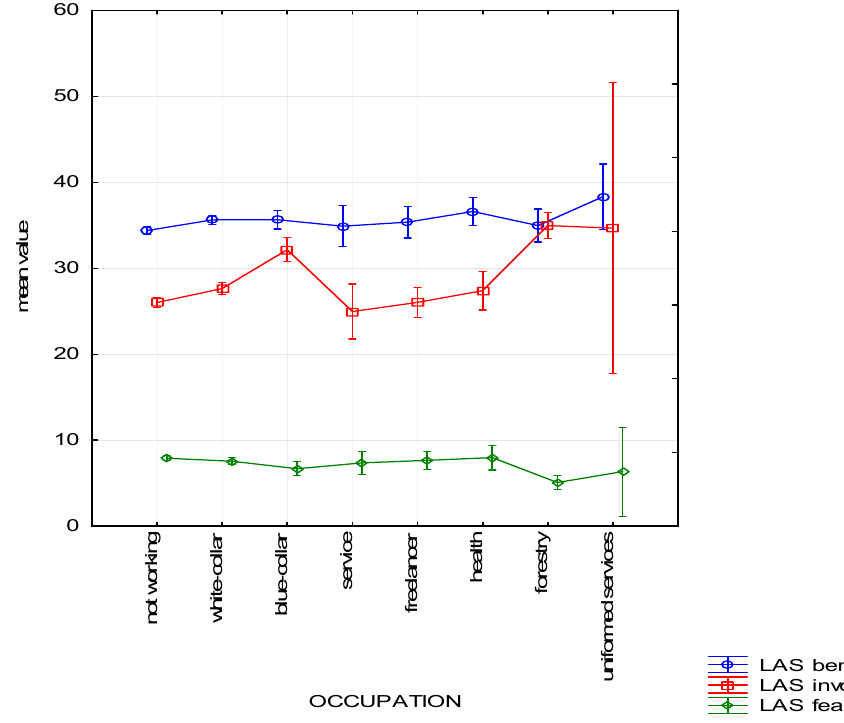
Figure 5. Attitude to the forest—mean chart for groups based on type of occupation. The assumptions were also corroborated by a post-hoc analysis. People professionally connected with the forest in reference to Fears do not differ statistically significantly from uniformed services and blue-collar workers (physical workers) and services. As far as Involvement is concerned, they differ from white-collar workers, freelancers and services, and health workers, but they do not differ from uniformed services and blue-collar workers (physical workers). In this area, blue-collar workers differ from other groups, apart from forest workers and uniformed services. In the Benefits subscale, the statistically significant differences occurred only between professionally inactive people and white-collar